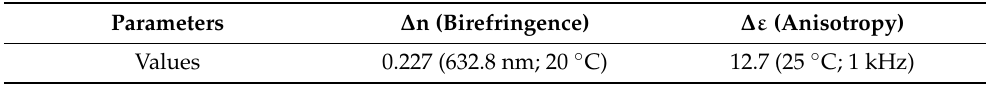
Table 1. Parameter values of nematic LC E 7 .